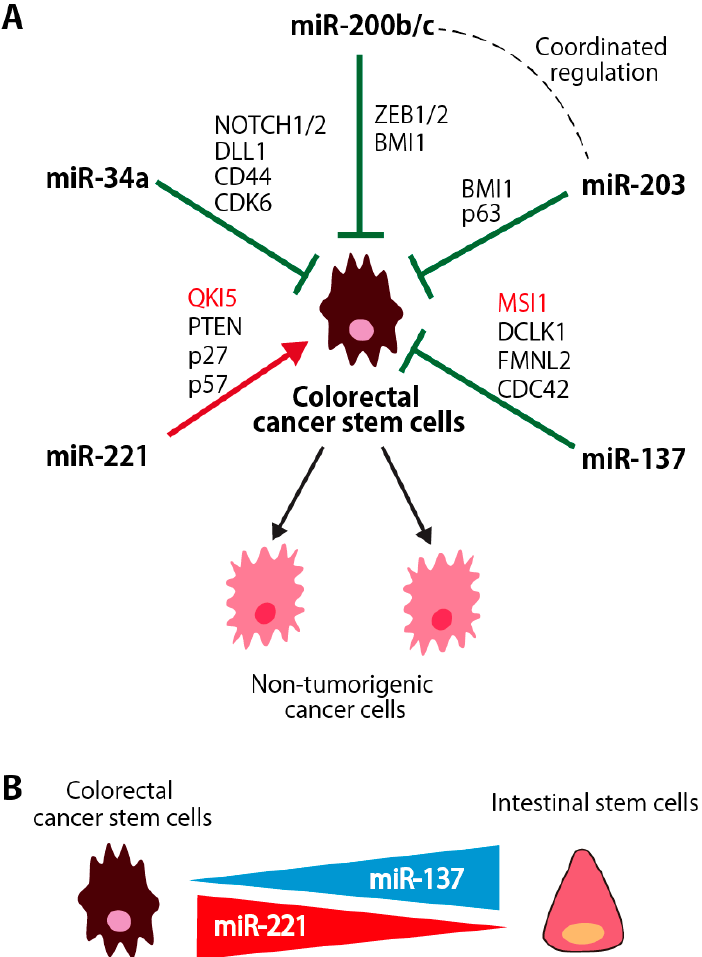
Figure 2. miRNAs involved in the regulation of colorectal CSCs. ( A ) Schematic illustration of the miRNAs that regulates colorectal CSC functions and their targets. miR-34a, miR-200b/c, miR-203 and miR-137 are downregulated in colorectal CSCs and suppress the stem cell properties of CSCs. Among them, the expression of miR-200bc and miR-203 is coordinately regulated, and these miRNAs coordinately function for the suppression of the stem cell properties of CSCs. In contrast, miR-221 is highly expressed in CSCs and enhances the stem cell properties of CSCs. These miRNAs target genes involved in the regulation of CSC properties. RNA-binding proteins shown in red font are described in detail in Chapter 4; ( B ) Differential expression of miRNAs between colorectal CSCs and normal intestinal stem cells. miR-221 and miR-137 are more highly expressed in colorectal CSCs and in normal intestinal stem cells than their counterpart,